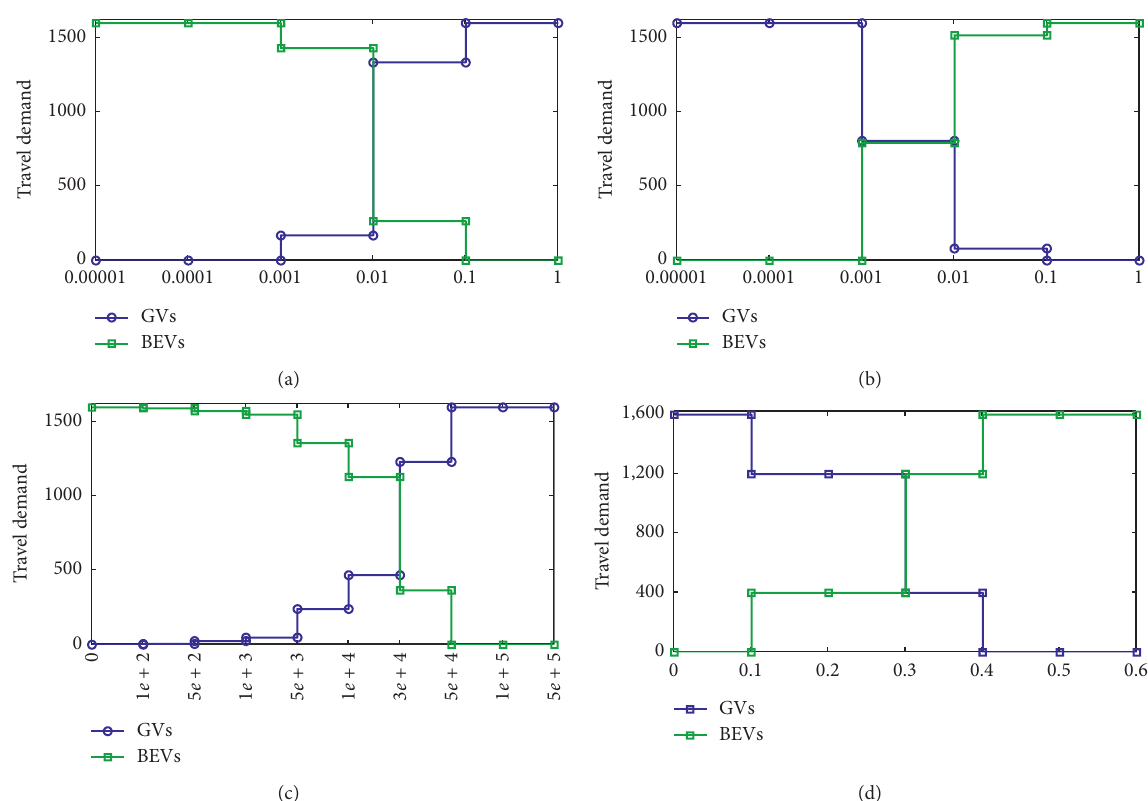
Figure 6: Total traffic flow. (a) Unit operating cost of EVs. (b) Unit operating cost of GVs. (c) Unit credit cost of GVs. (d) Unit price λ